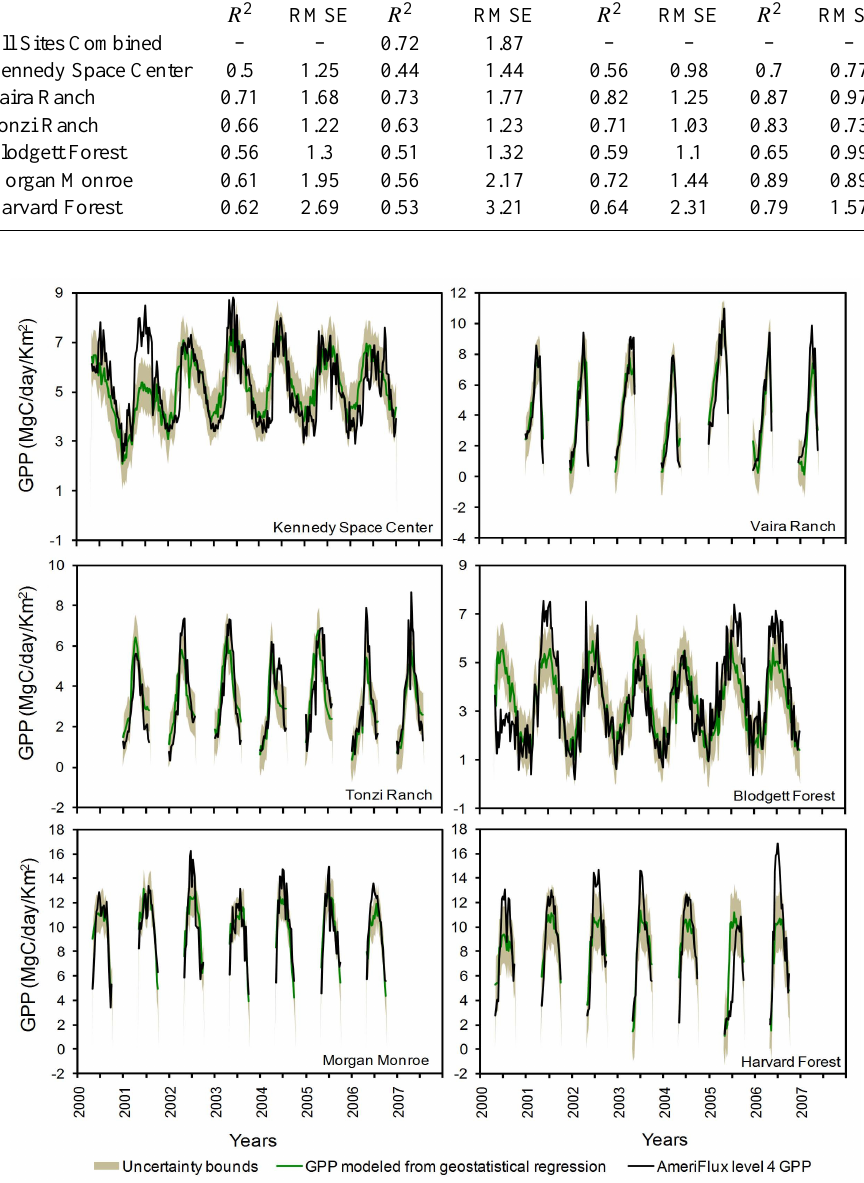
Fig. 3. AmeriFlux level 4 GPP and GPP estimated from the best GR model ( X ˆ β ) at the 8-day scale, with one standard deviation uncertainty bounds estimated as the square root of the sum of the uncertainty variance of X ˆ β (Eq. 6), and the estimated variance of the residuals ( σ 2 Eqs. 1 and